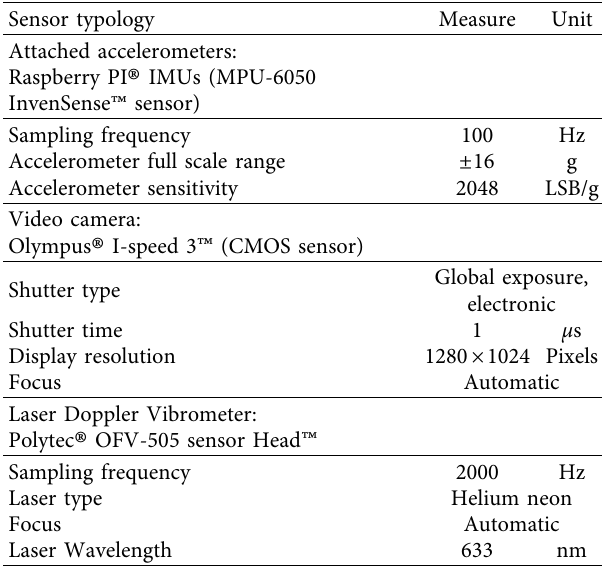
Figure 3: The second experimental setup (cantilevered box beam, Cranfield University). Table 1: Details of the measurement equipment (wing spar and box